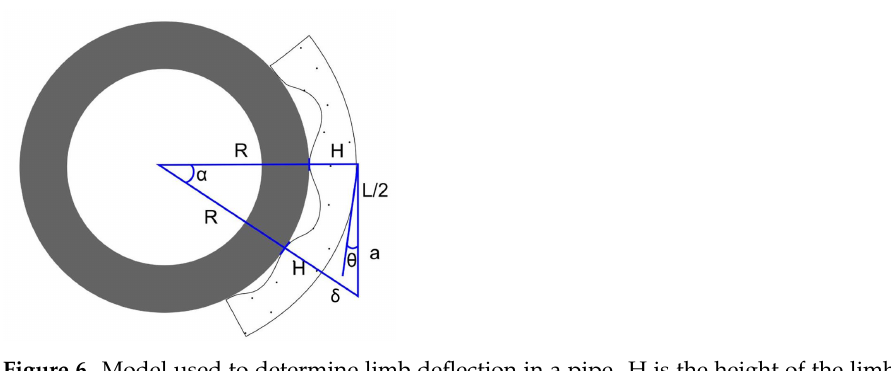
Figure 6. Model used to determine limb deflection in a pipe. H is the height of the limb, L is the length of the link, R is the radius of the pipe, θ is the deflection of the joint, and α is the angle between the contact points of two consecutive links.